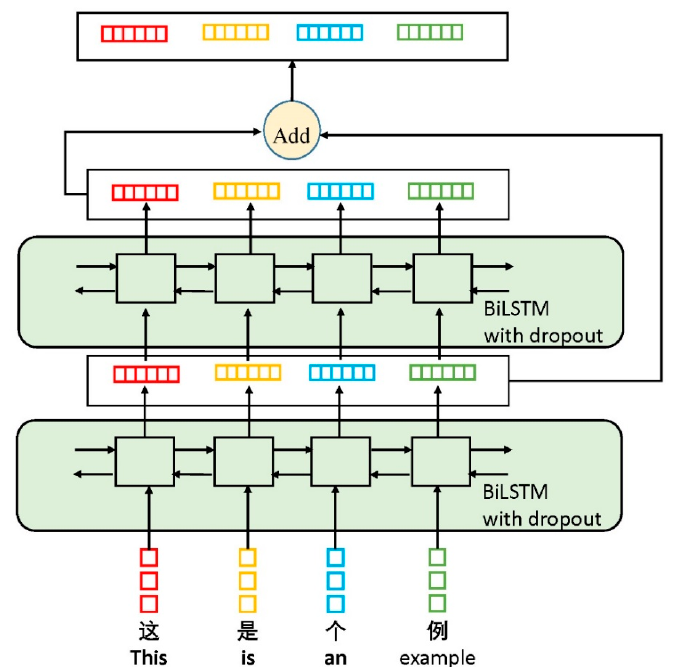
Figure 3. The basic structure of the enhanced encoding layer in the En2BiLSTM-CRF model.